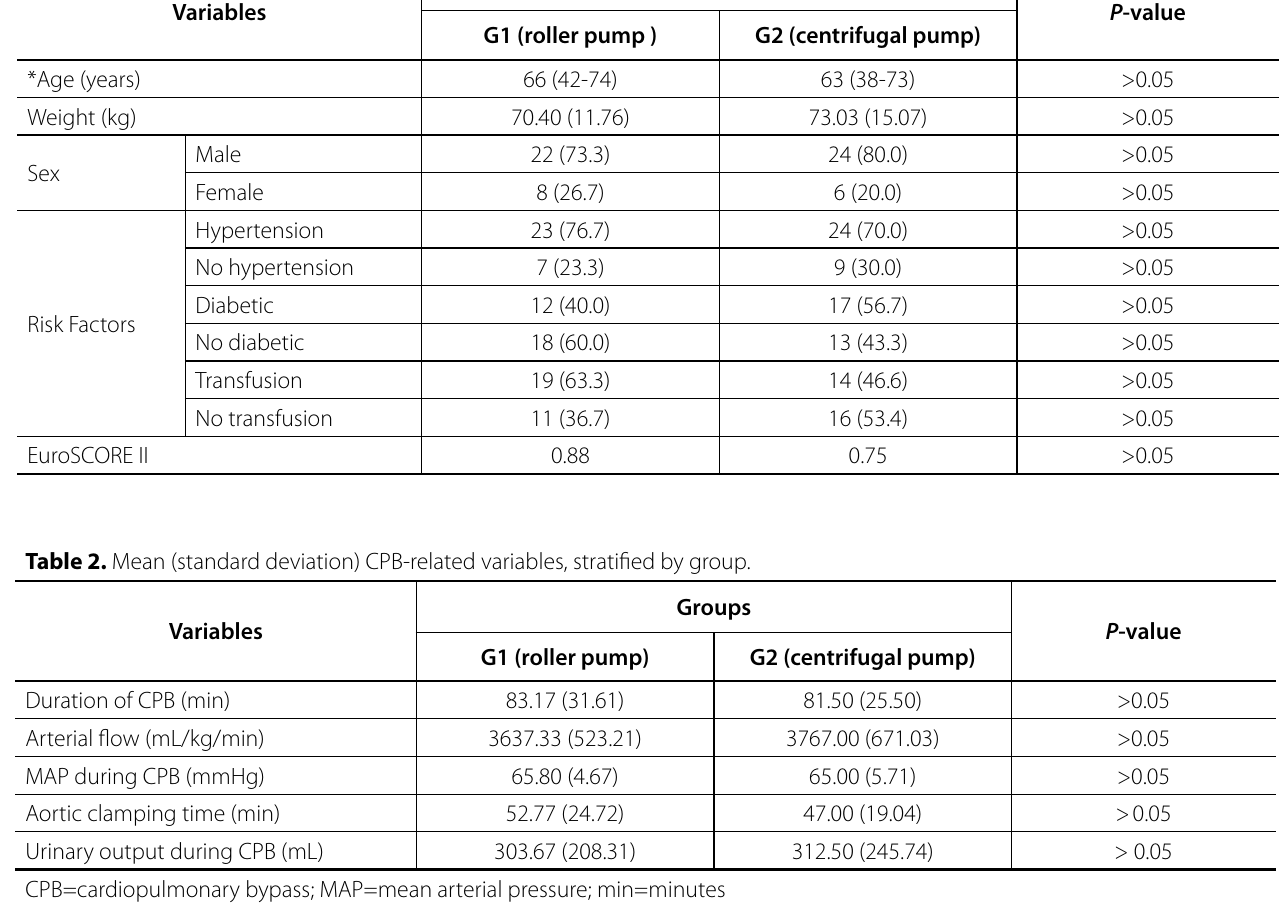
Table 3. Median (range) haptoglobin levels, stratified by group and time